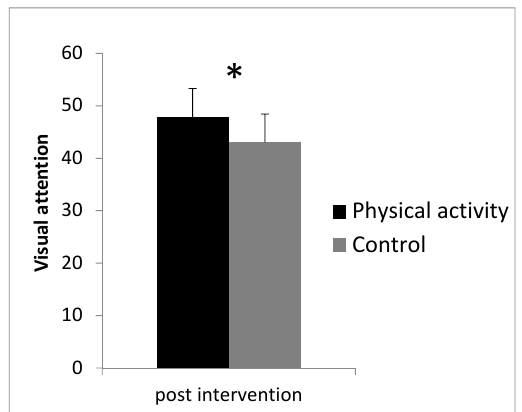
Figure 3. Visual attention (according to the average number in the Zahlen-Verbindungs-Test) separately for each group. Error bars represent standard deviations. * indicates a significant group effect.